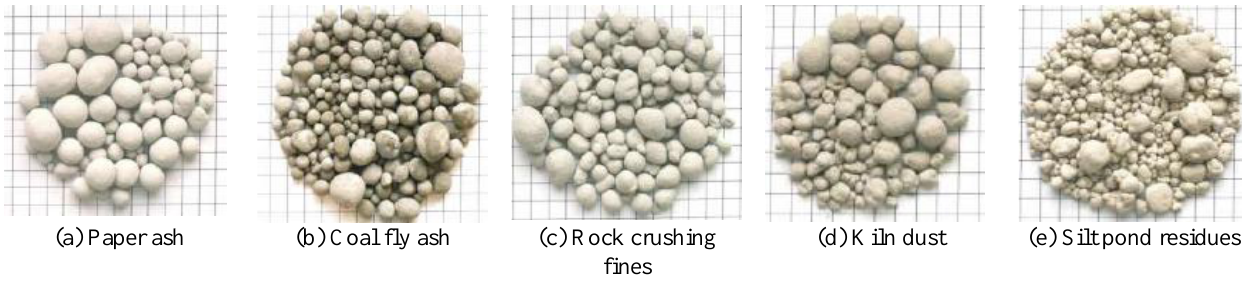
Figure 7. Aggregates manufactured from various industrial wastes by the carbonation process (from Carbon 8 Systems Ltd [30] with permission of P.